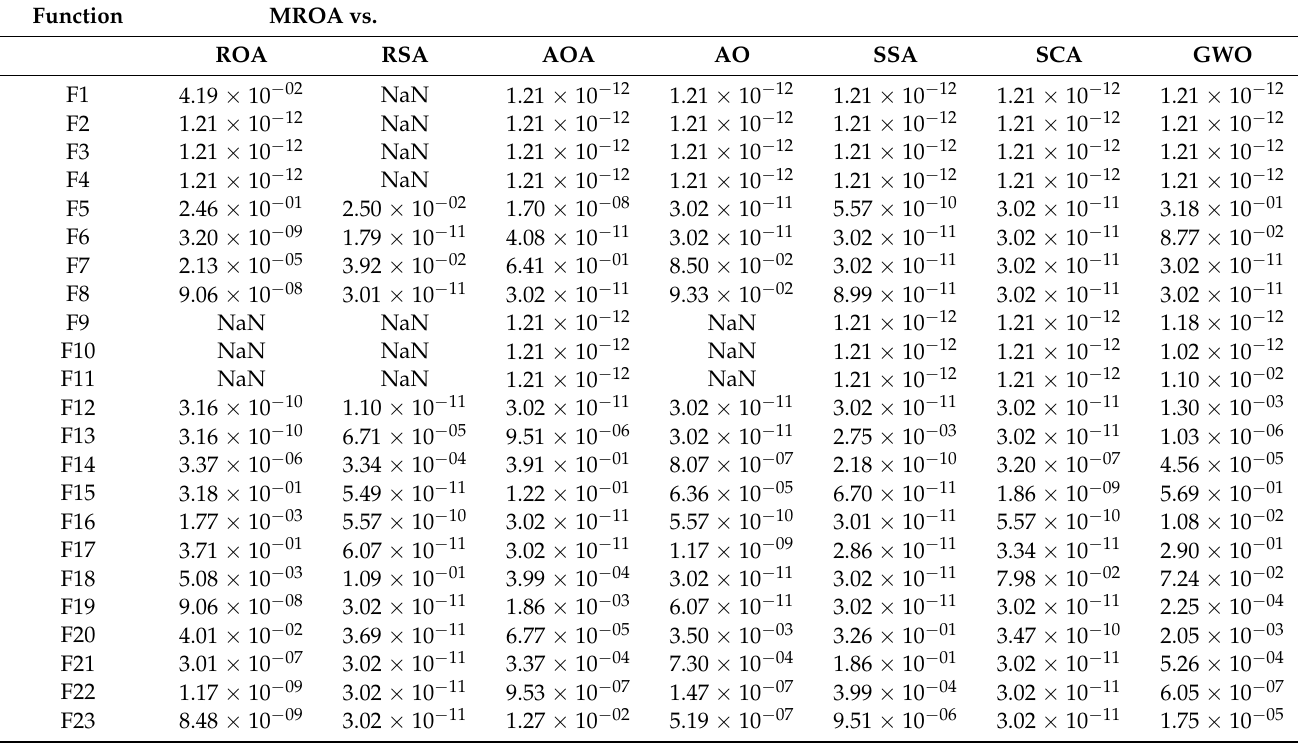
Table 4. Statistical results of algorithms on 23 benchmark functions using Wilcoxon rank-sum